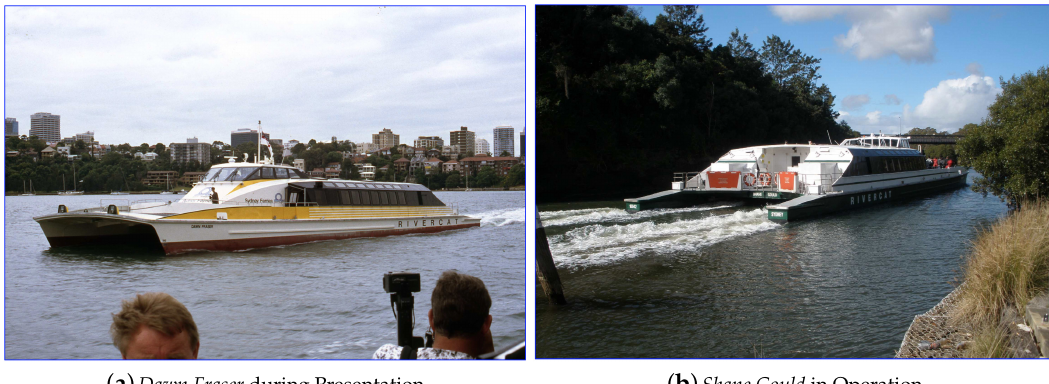
Figure 1. Grahame Parker Design Pty Ltd Sydney RiverCat.